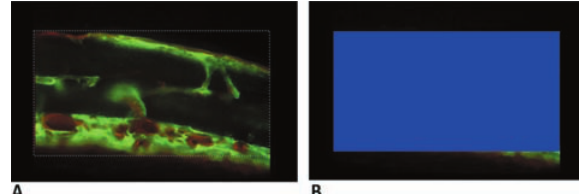
Figure 6- Image superposition scheme. The calcein and the alizarin images were superimposed in a computer program to obtain the final studied images